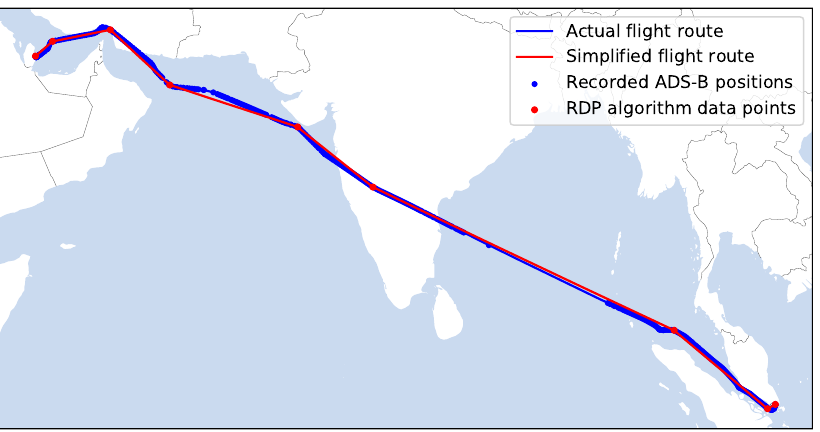
Figure 2. Simplification of an example flight route using the RDP algorithm with (cid:101) =